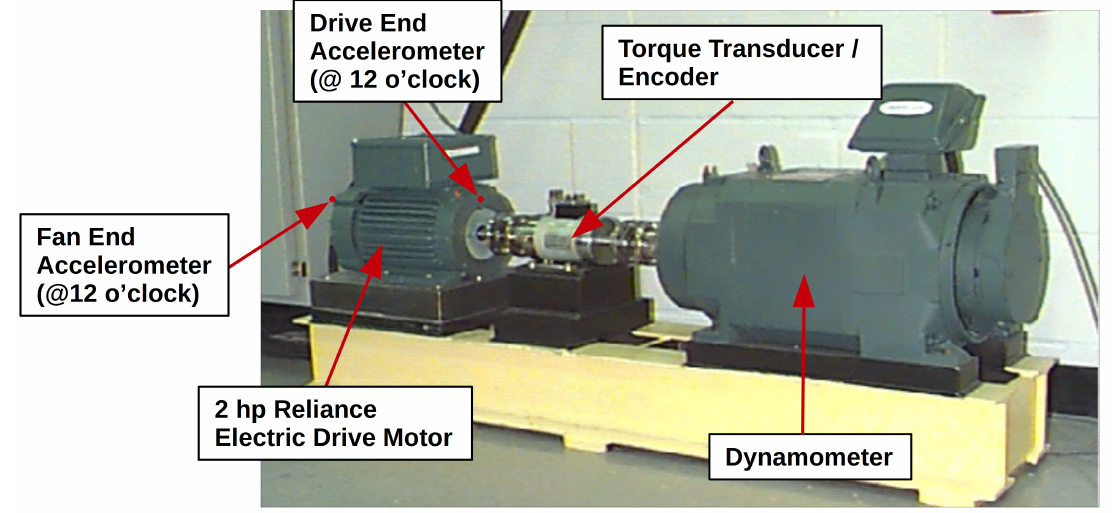
Figure 5. The Case Western Reserve University Bearing Center test apparatus (original image taken from